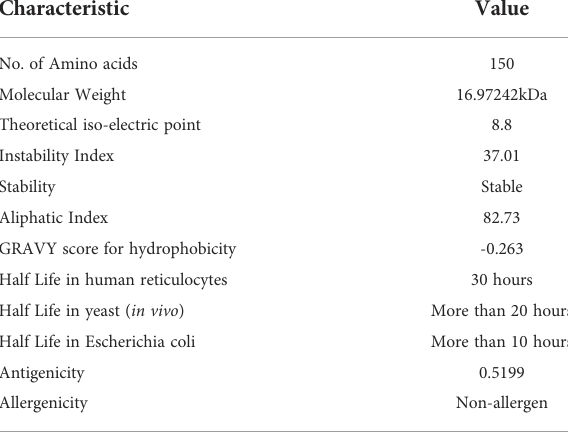
TABLE 2 Immunogenic and physicochemical pro fi le of proposed MEMPV. Characteristic